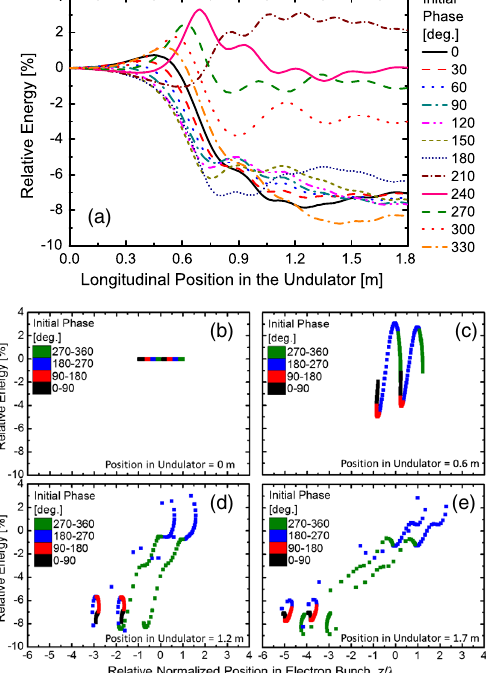
FIG. 12. Evolution of the energy of electrons with different initial phases in the undulator at the end of the macropulse. (a) Variation in relative energy along the undulator. The electrons in one wavelength slice at the center of the electron bunch are plotted. (b – e) phase space plots of the two wave- length slices of the electron beam at the center of the electron bunch and at the different longitudinal position in undulator. The longitudinal position in the undulator for (b), (c), (d), and (e) are 0, 0.6, 1.2, and 1.7 m, respectively. The horizontal axis is relative position in the electron bunch normalized by the lasing wavelength λ ¼ 11 . 6 μ